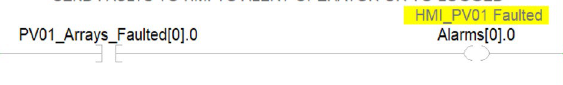
Fig. 5 Example of faults sent to